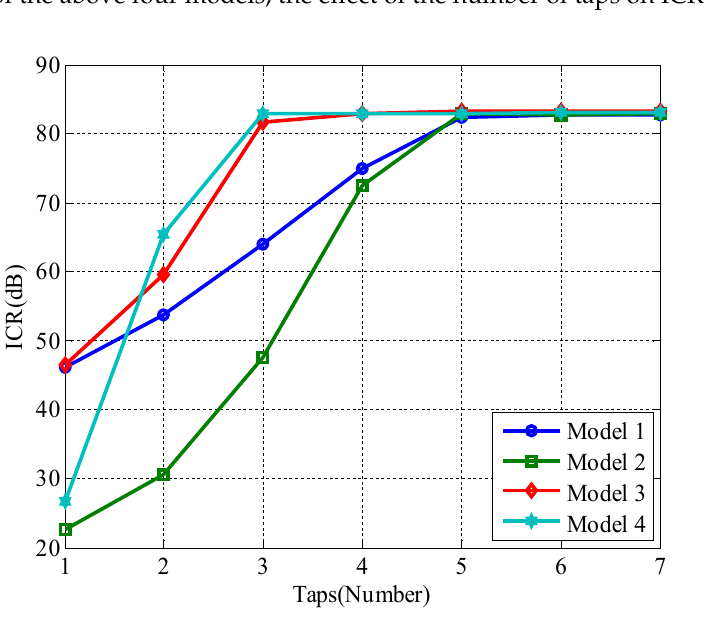
Figure 9. Impact of taps on ICR with multipath.